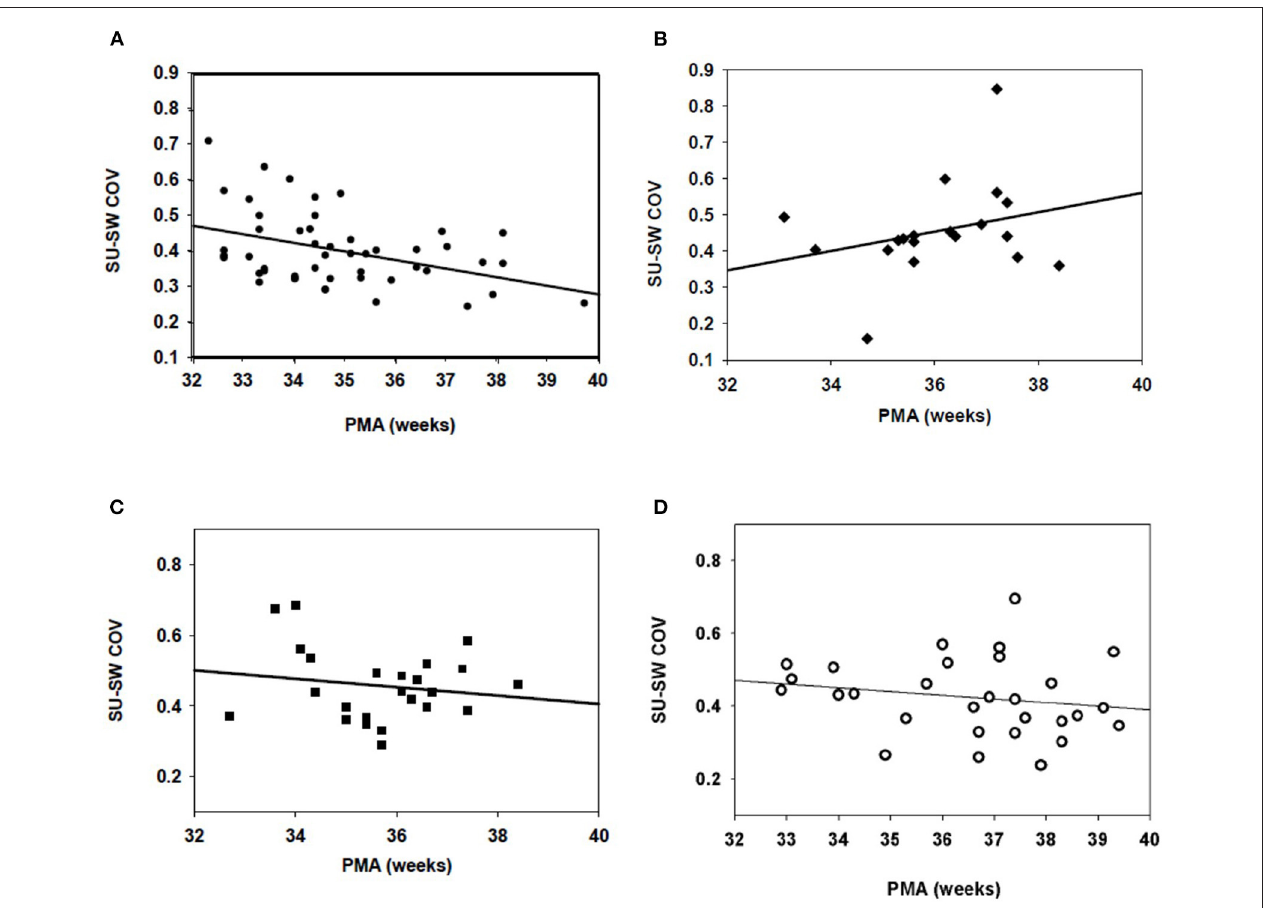
FIGURE 1 | Suck-swallow (SU-SW) dyadic COV in infants 32–40 weeks PMA. (A) In 21 low risk preterm (LRP) infants (53 individual studies), there was a statistically significant ( p > 0.05) inverse regression between Suck-Swallow COV and 32–40 weeks PMA ( R = 0.407). (B) In 10 infants with BPD (22 feeds) there was no correlation between time from 32 to 40 weeks and suck-swallow COV. R = 0.181; p = NS). (C) In babies with IVH (but no BPD), N = 7 (24 studies), there was no improvement in Suck-Swallow COV between 32 and 40 weeks PMA ( R = 0.161; p = NS). (D) In infants with both IVH and BPD ( N = 9; 32 studies), there was also no further improvement in Suck-Swallow COV between 32 and 40 weeks PMA ( R = 0.184; p =